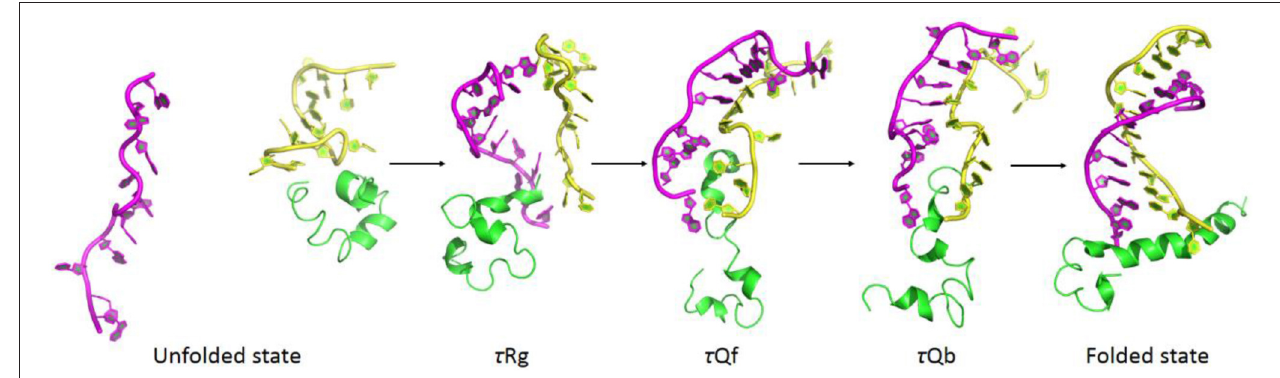
FIGURE 13 | Average structures along binding and folding pathways of DNA/RNA hybrid, green regions for polymerase, yellow regions for the DNA, and magenta regions for the RNA. The binding and folding pathways are along (1) > 15 ns (unfolded state), (2) 4.24 ns ( τ Rg), (3) 1.71 ns ( τ Qf), (4) 1.21 ns ( τ Qb), and (5) folded